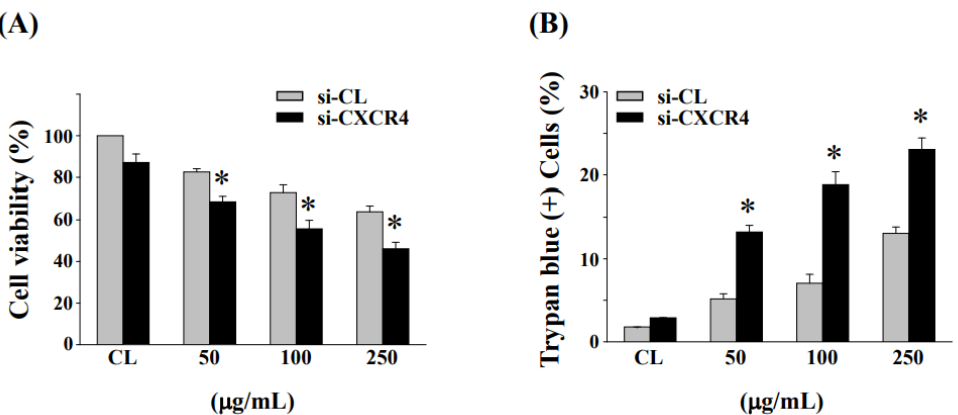
Figure 6. Downregulation of CXCR4 expression enhanced the fermented NaDES-ginger extract-induced cytotoxicity and cell death. ( A ) HCT-116/R cells were transfected with siRNA against CXCR4 (si-CXCR4) or scrambled (si-CL) in the complete medium for 24 h prior to the treatment with fermented NaDES-ginger extract (50 – 250 g/mL). Cytotoxicity was determined by ( A ) MTT assay and ( B ) trypan blue exclusion assay. The results (mean ± standard error of the mean) were from three independent experiments. * p < 0.05 vs. si-CL-transfected cells. 3.7. Inhibition of NF- B Activation Enhances the Reduction in CXCR4 Expression in HCT-116/R Cells HCT-116/R cells were treated with fermented NaDES-ginger extract (50 and 100 μg/mL) for 24 h, and then , the activation of NF- B was analyzed by NF- B transcription factor activity assays. Cells treated with fermented NaDES-ginger extract resulted in a significant decrease in NF- B p65 activity compared to the untreated control (Figure 7A). To determine whether CRCR4 expression in HCT-116/R cells is regulated by NF- B, cells were pretreated with DMSO or PDTC, a specific inhibitor for NF- B, for 1 h and then treated with fermented NaDES- ginger extract (50 and 100 μg/mL) fo r 24 h. Pretreating HCT-116/R cells with NF- B inhibitor enhanced the expression of fermented NaDES-gin- ger extract-reduced CXCR4 mRNA as compared with DMSO-pretreated cells (Figure 7B). Figure 7. Fermented NaDES-ginger extract decreased CXCR4 expression via NF- B inactivation in HCT-116/R cells. ( A ) HCT-116/R cells were cultured in a complete medium, and then, 50 or 100